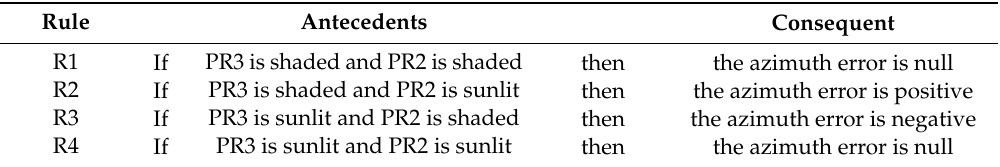
Table 4. Action rules for the azimuth error (PR3 and PR2).